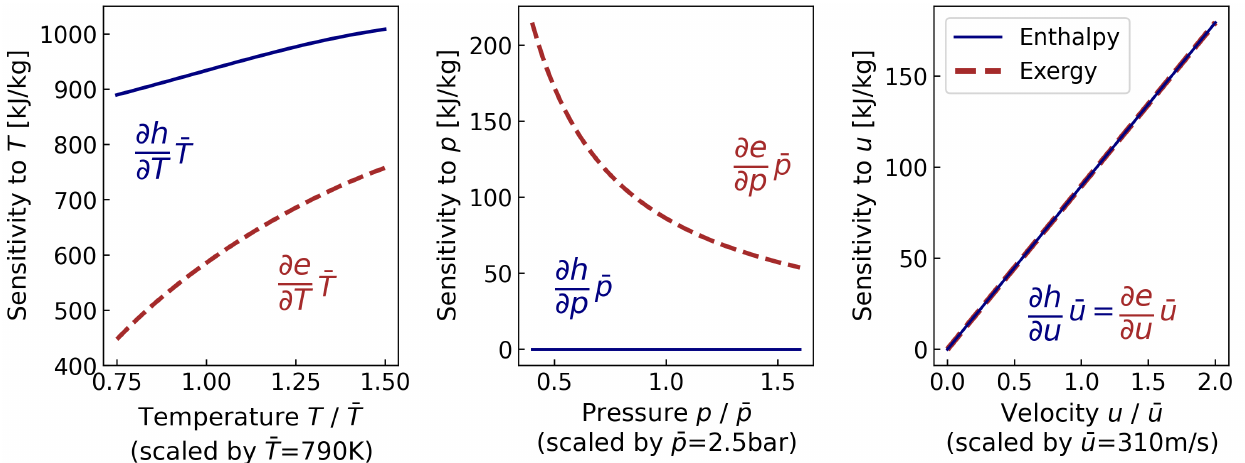
Figure 8. Gradient-based sensitivity of specific enthalpy and exergy (kJ/kg) with respect to flow